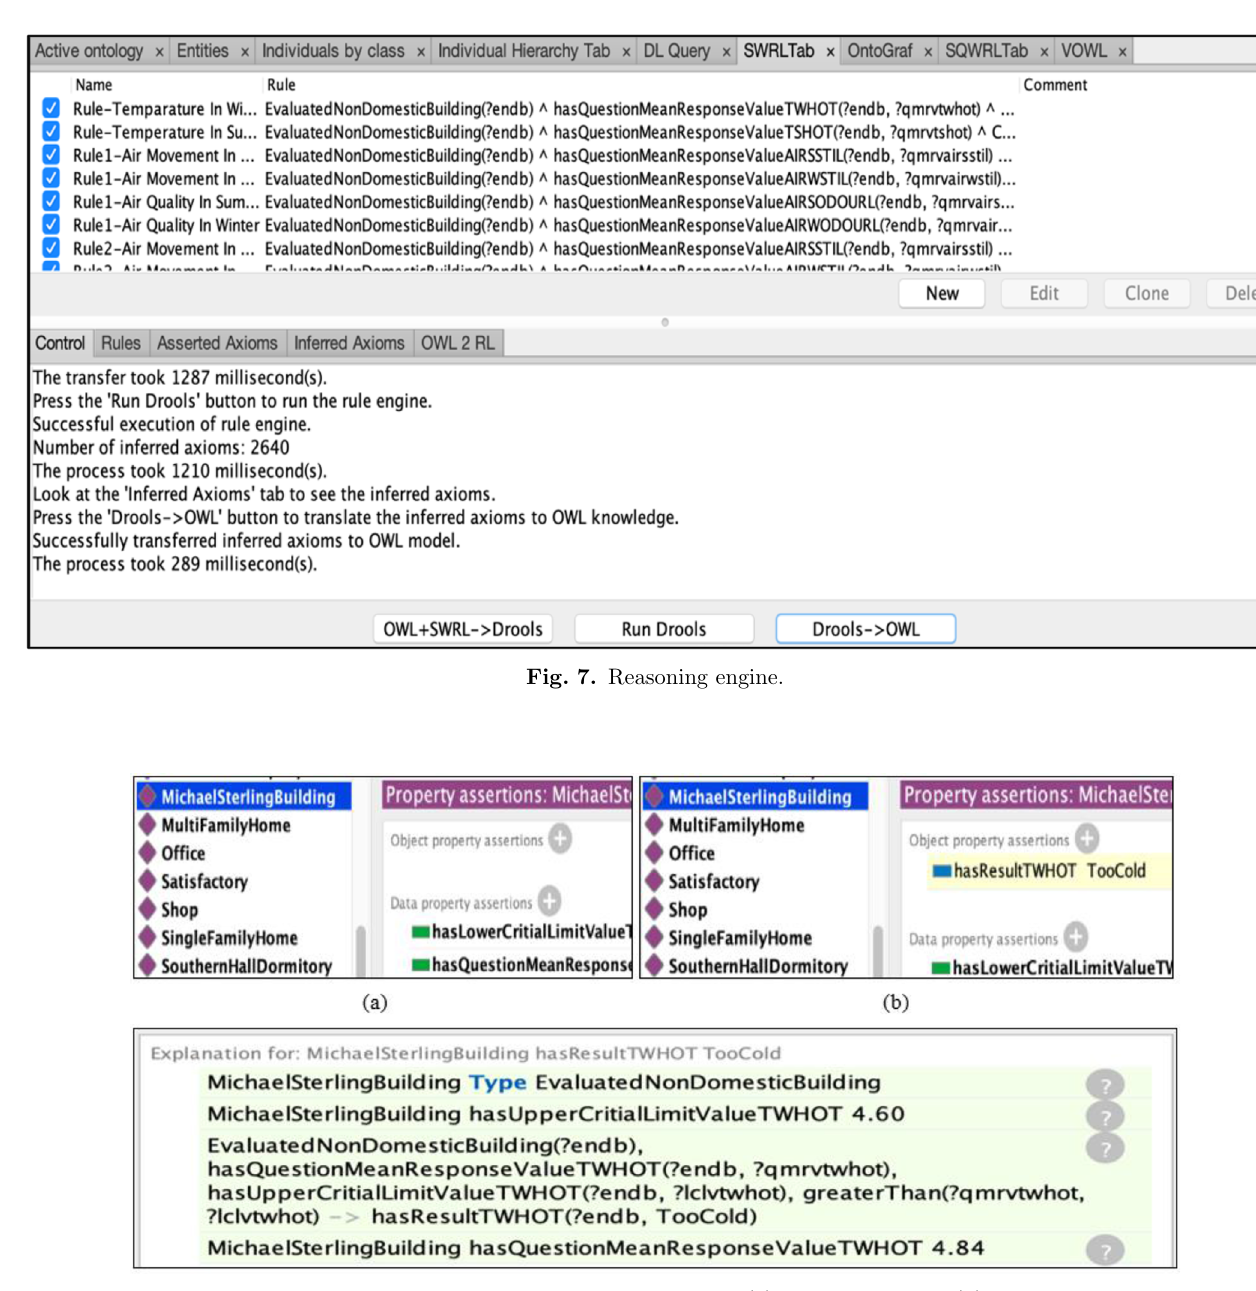
Fig. 8. Translate the inferred axioms to OWL knowledge (a) before reasoning. (b) after